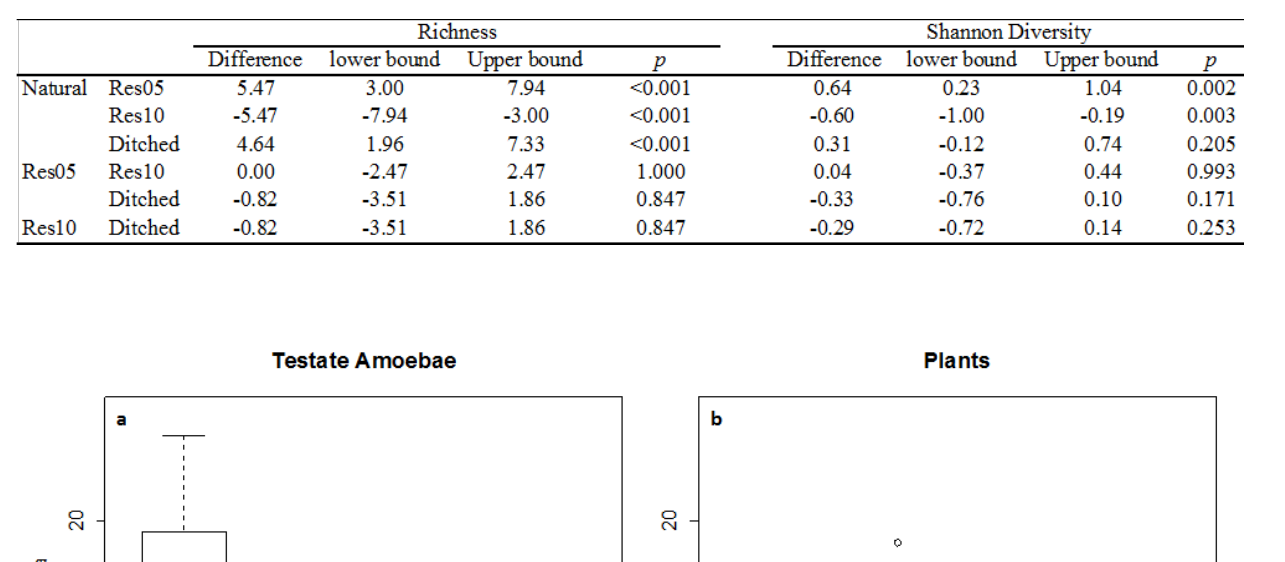
Table 1. Tukey’s (HDS) results for TA taxon richness and Shannon diversity. Res05: peatlands restored 3–7 years ago; Res10: peatlands restored 9–12 years ago.